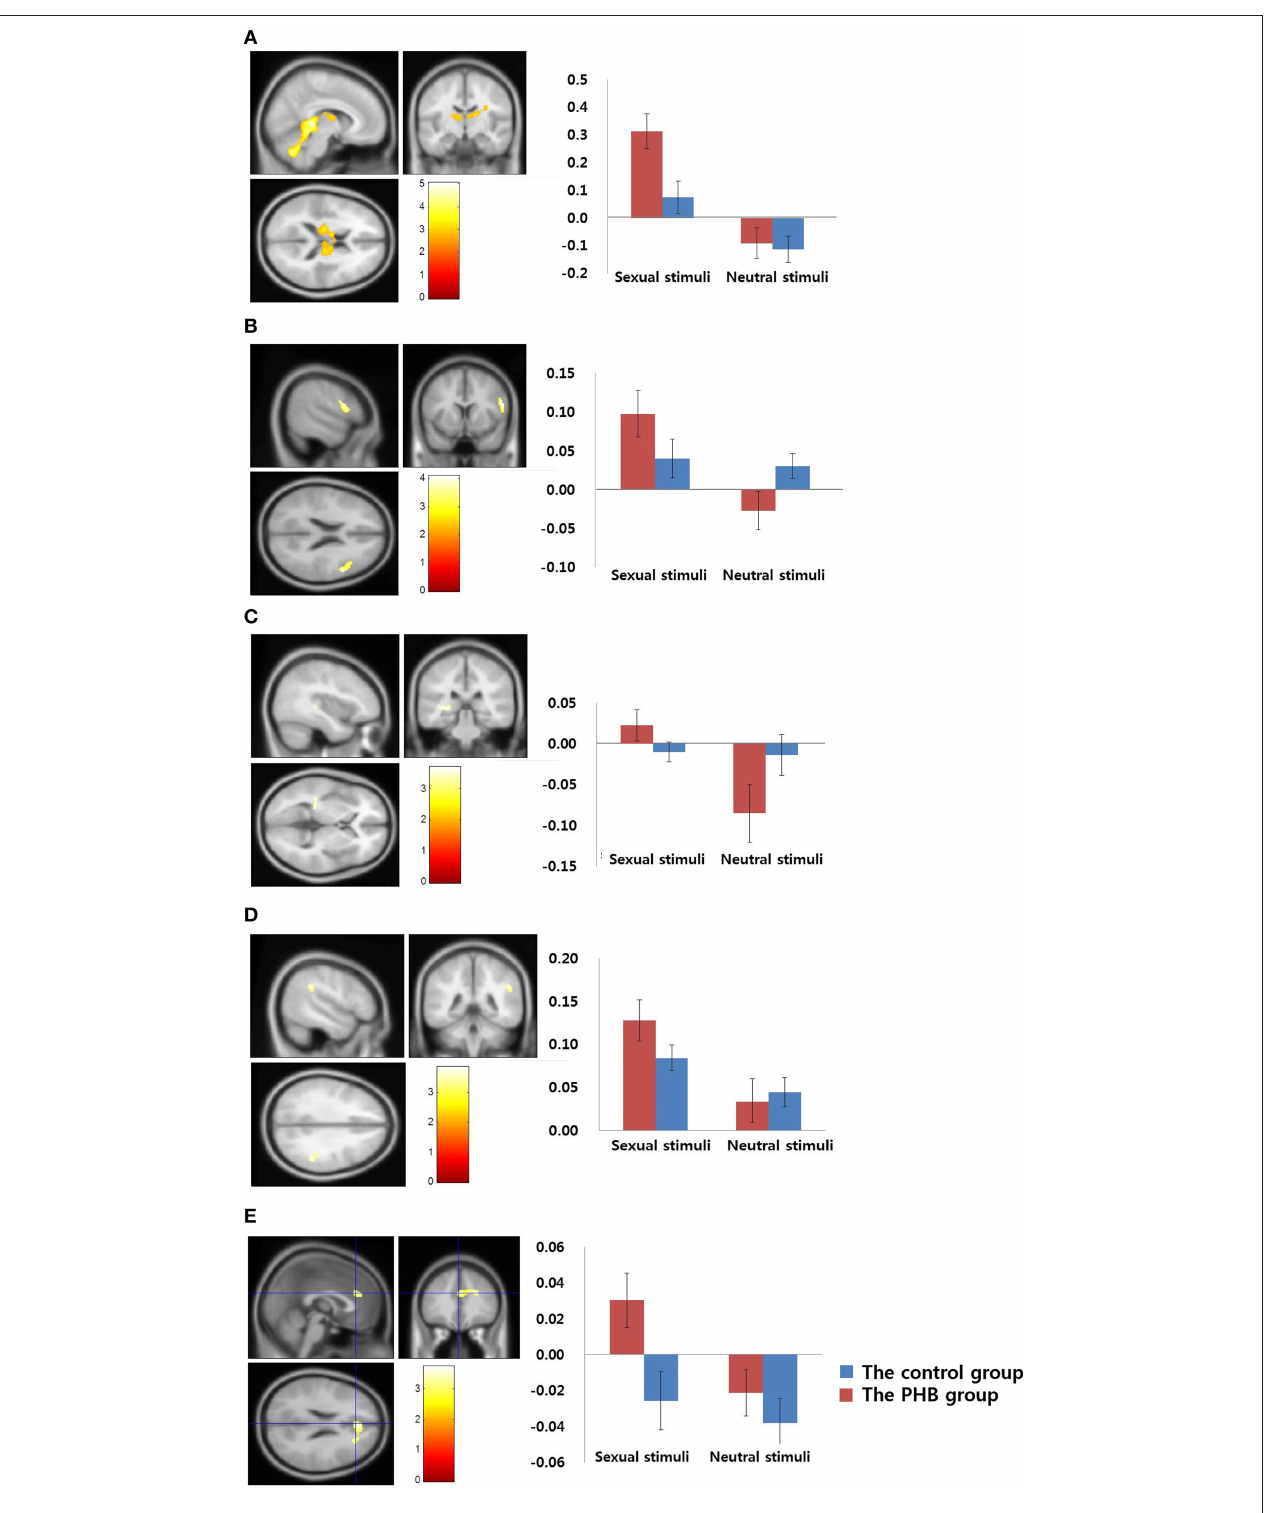
FIGURE 2 | Results of the between-group analysis. (A) Bilateral thalamus (MNI coordinate; x = 6 , y = − 36 , z = 4 ) (B) Right dorsolateral prefrontal cortex (MNI coordinate; x = 56 , y = 10 , z = 22 ) (C) Left caudate nucleus (MNI coordinate; x = − 38 , y = − 32 , z = 2 ) (D) Right supramarginal gyrus (MNI coordinate; x = 50 , y = − 42 , z = 32 ) (E) Right dorsal anterior cingulate gyrus (MNI coordinate; x = 24 , y = − 16 , z = 34 ). Results of the comparisons of activation in sexual stimuli minus nonsexual stimuli between the PHB and control groups ( p < 0.05 , False Discovery Rate, corrected). The control group and the PHB group are represented as blue and red, respectively. The y-axis shows the percent signal change and the error bars represents Standard Error of the Mean.